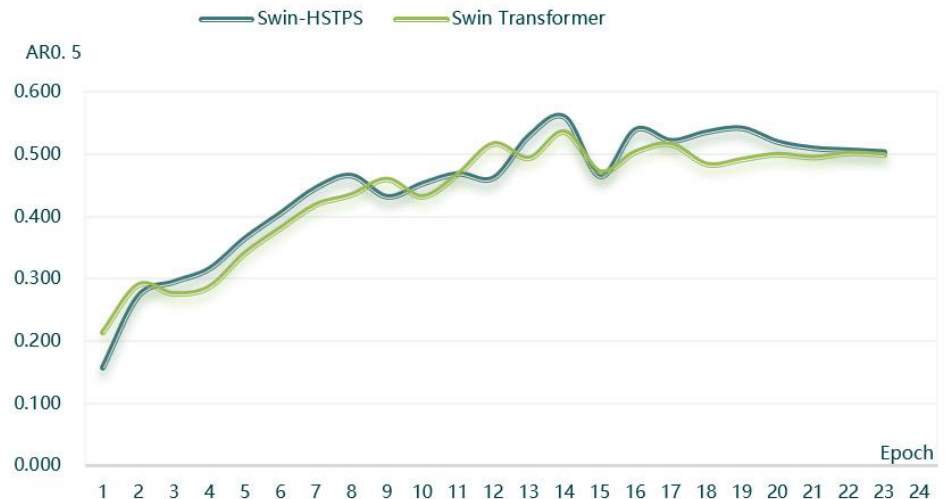
Figure 6. Average recall rate comparison chart (AR 0.5 ).